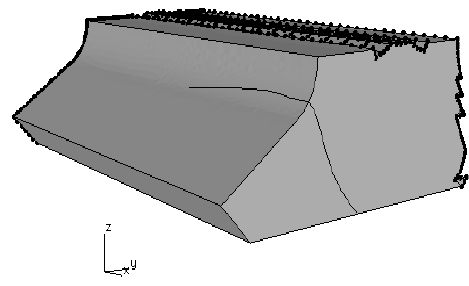
Figure 15. The 60 ◦ angle, short flank crack shape. Figure 15. The 60° angle, short flank crack shape. Figure 15. The 60° angle, short flank crack shape.